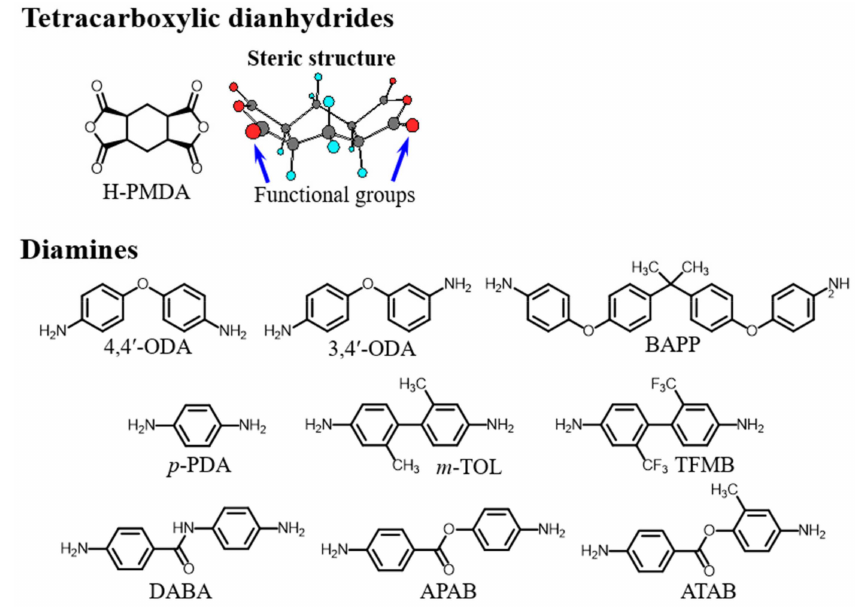
Figure 3. Structures of H-PMDA and common diamines used in this